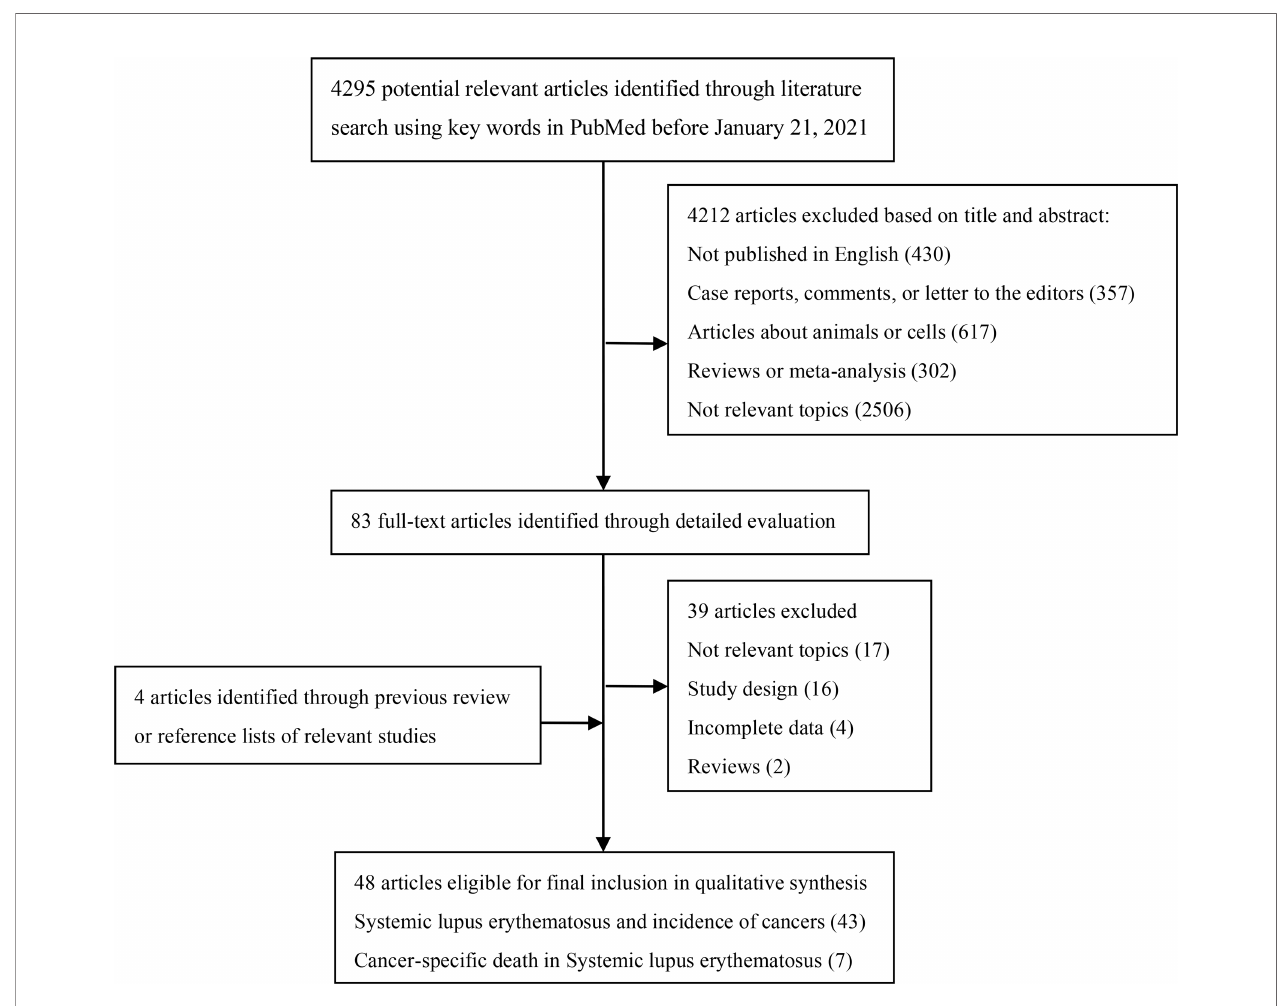
FIGURE 1 | Flow diagram of literature search and study